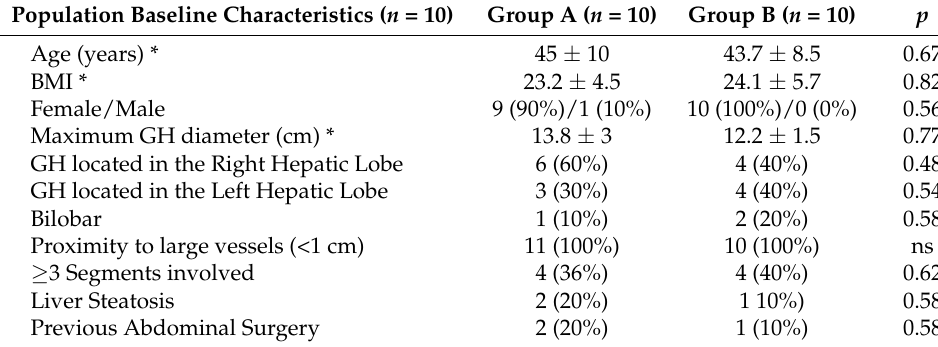
Table 1. Population baseline characteristics.